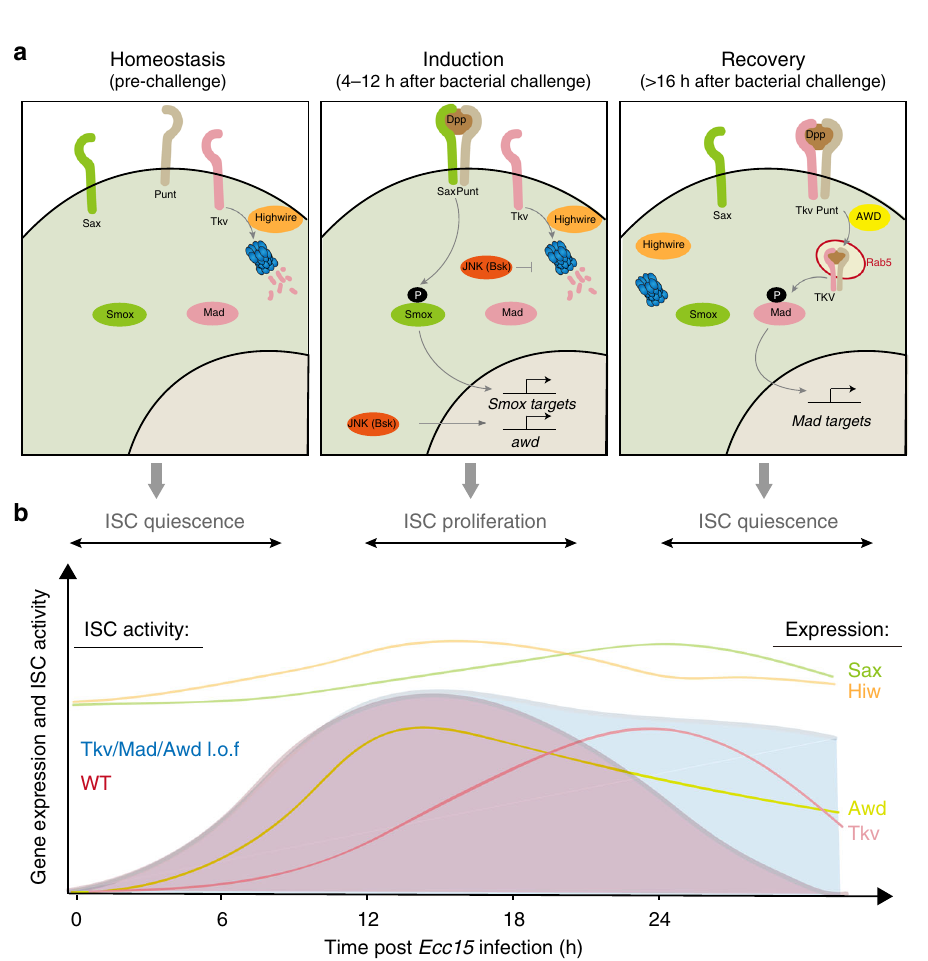
Fig. 7 Model. a Model for the dynamic control of ISC activity by AWD-facilitated endocytic regulation of Tkv/MAD signaling during the regenerative response. Under homeostatic conditions, Highwire and proteasomes maintain high turn-over of Tkv protein, leading to its absence in ISCs. During the early induction phase after infection, Dpp ligands fi rst bind to constantly expressed Sax, promoting ISC proliferation through Smox signaling. Meanwhile, activated JNK stabilizes Tkv on ISC membrane, potentially by inhibiting proteasomal activity, while upregulating AWD expression. During the late recovery phase, stabilization of Tkv protein followed by AWD-facilitated internalization to early endosomes switches on MAD signaling, allowing a return to ISC quiescence. b Timeline of ISC proliferation and relative expression of Tkv/Sax/Highwire/Awd during one regeneration